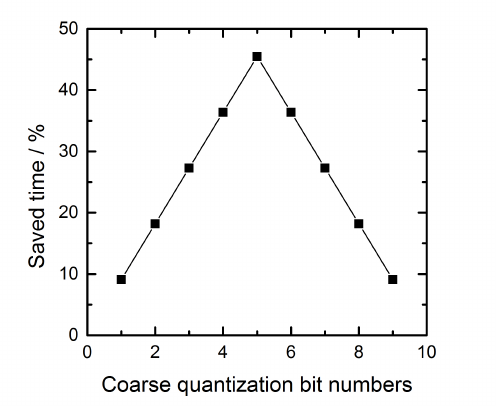
Figure 3. Relation curve between the saved time of SAR ADC and coarse quantization bit